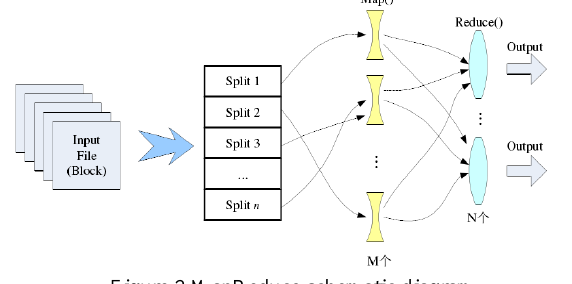
Figure 2 MapReduce schematic